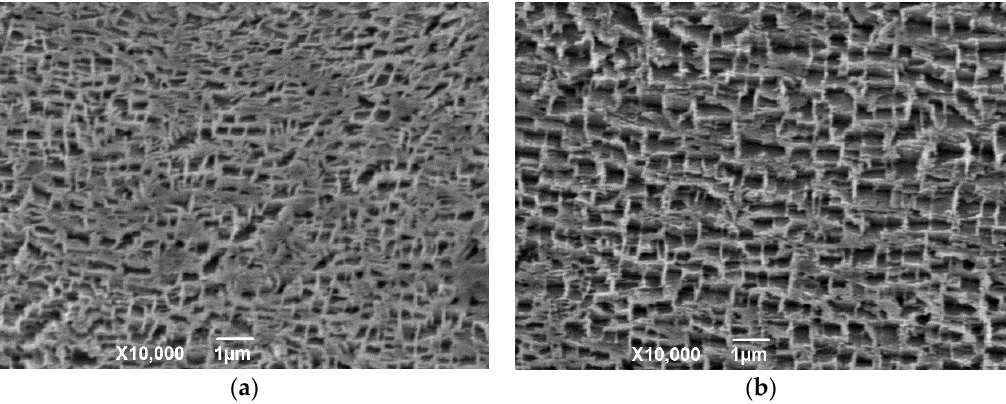
Figure 9. Detailed view of ( a ) domain A and ( b ) domain B in Figure 5d.